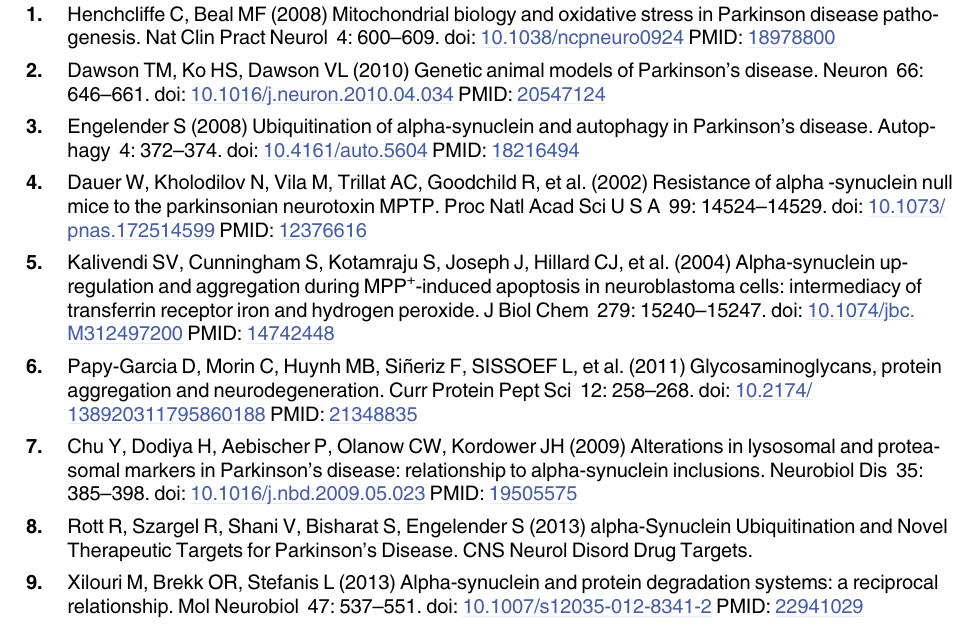
S2 Fig. Caspase-3 and -9 activities. Caspase-9 and -3 activities were measured at 6 and 24 h, respectively after the end of MPP + treatment, using a specific fluorescent substrate, Ac-LEHD- AFC for caspase-9 (a) and Ac-DEVD-AFC as substrate for caspase-3 (b). Results are expressed as percentage of unstressed control group and represent three independent experiments in trip- licate. Results are the mean ± S.E.M. (cid:1)(cid:1)(cid:1) p < 0.01 compared to control cells. Cells treated under various conditions were harvested through trypsinization and washed with PBS. The cell pellet was gently suspended in buffer containing 30 mM HEPES, 0.3 mM EDTA, 100 mM NaCl, 0.15% Triton X-100 and 10 mM DTT and centrifuged. The supernatant was used for the assay. Caspases substrates were added to a final concentration of 100 mM. The plate was covered, gently mixed and incubated at 37°C for 1 h. Then samples were measured at λ λ 505 nm in a fluorescent microplate reader (TECAN infinite M1000). em (TIF) S3 Fig. Co-localization of cathepsin D and glycosaminoglycans in MPP + -stressed cells. Immunofluorescence co-labeling of cathD (green) and endogenous HS-CS (red) in normal (Ctrl) and MPP + -stressed cells (6 h). Observations were done with a confocal microscope Zeiss Axio Observer Z.1. Stars and arrows indicate areas where co-localization is observed.